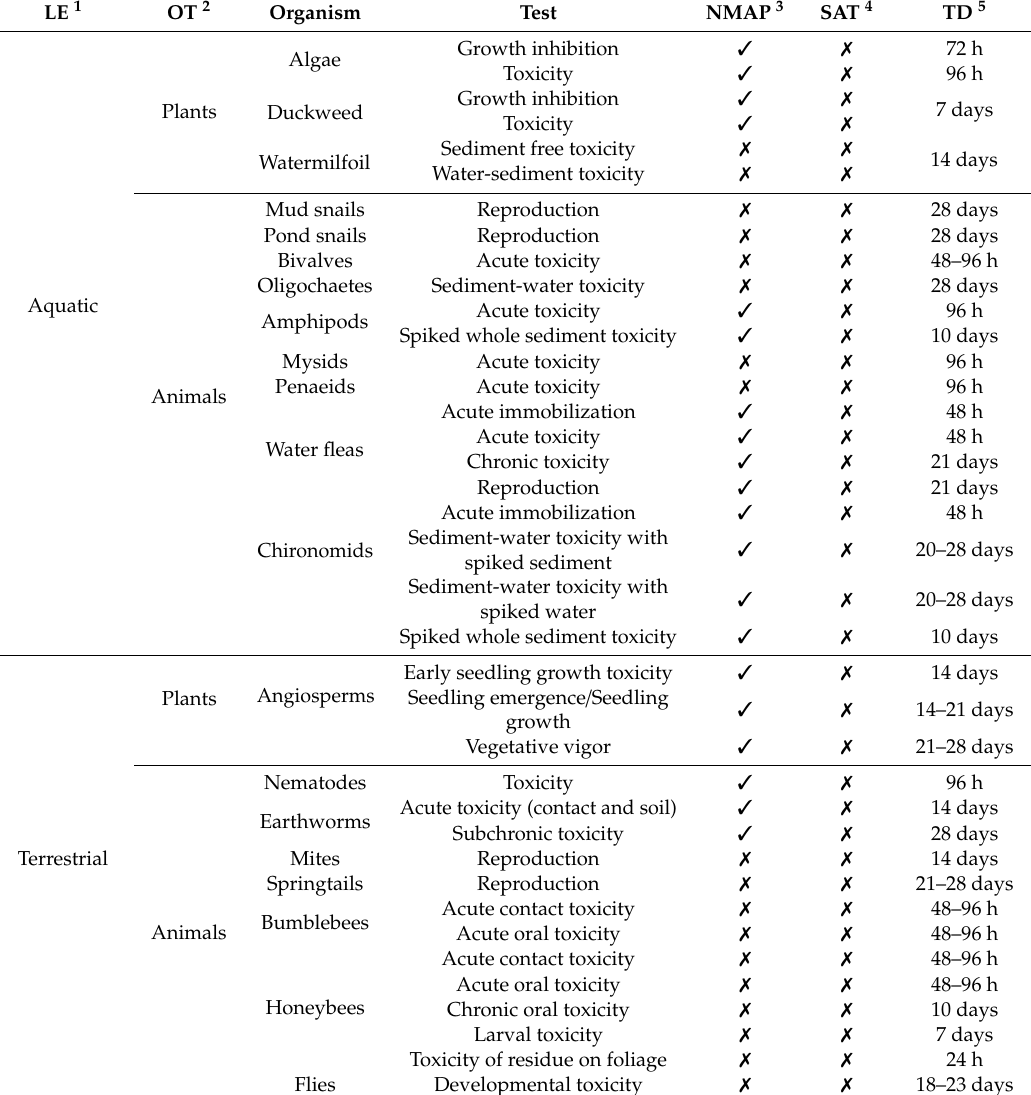
Table 4. Analysis of ecotoxicity assays that correspond to the criteria described above. For simplification of table only tests less than 30 days are showed.